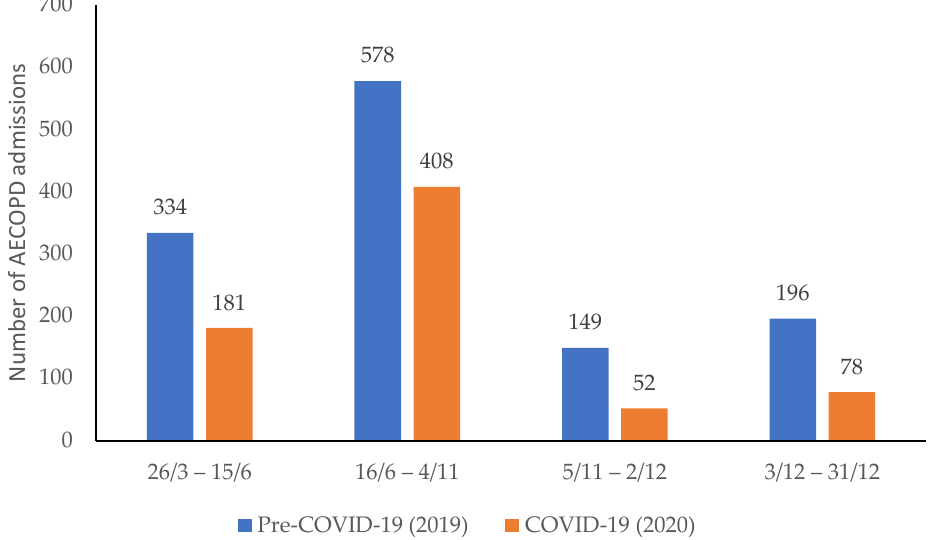
Figure 1. Hospital admission with COPD exacerbation (AECOPD) during COVID-19 period (Orange) compared with pre-COVID-19 period (blue). Numbers of admissions in the period are stated above each bar.